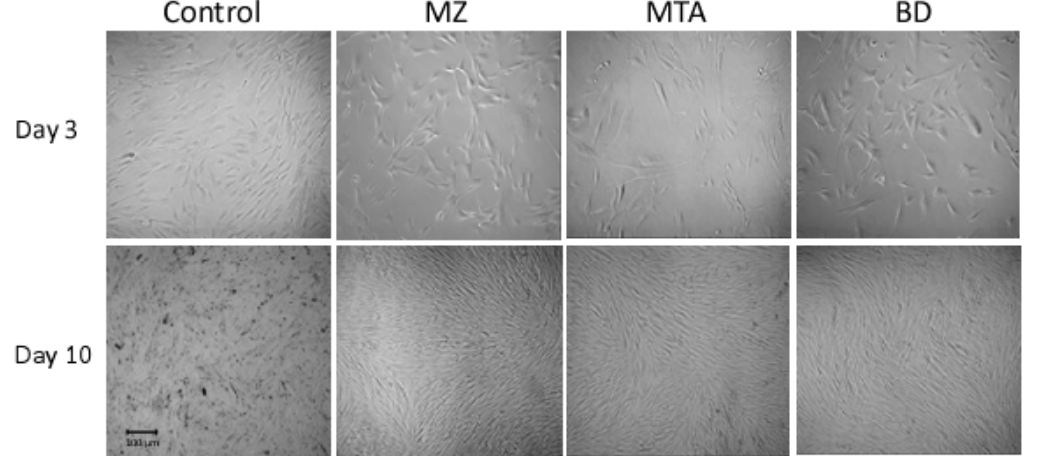
Figure 1. Cell morphology. Dental Pulp Pluripotent-like Stem Cells (DPPSCs) at day 3 (100×) and at day 10 (40×) of differentiation. BD, Biodentine; MZ, MedCem; MTA, Mineral Trioxide Aggregate; CT, Control